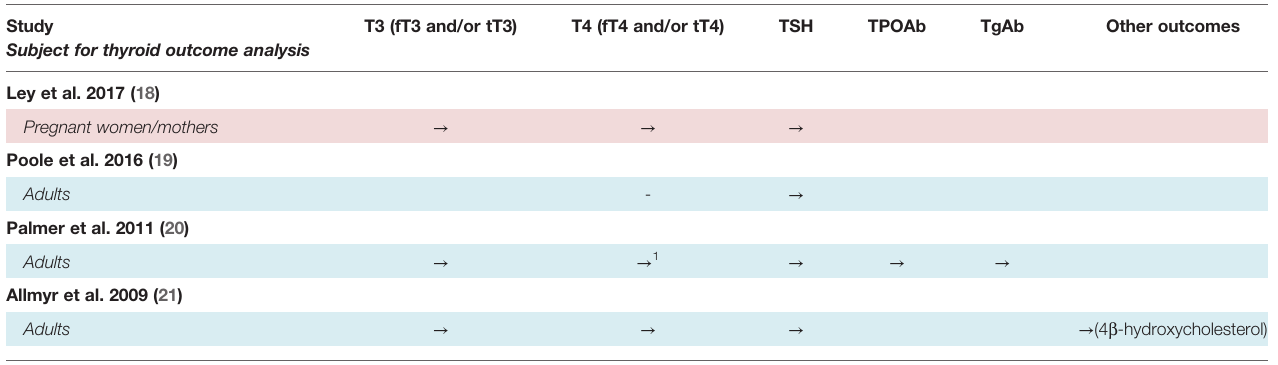
TABLE 3 | Summary of fi ndings of associations between triclosan concentrations and thyroid gland variables in interventional studies of human adults. Study T3 (fT3 and/or tT3)